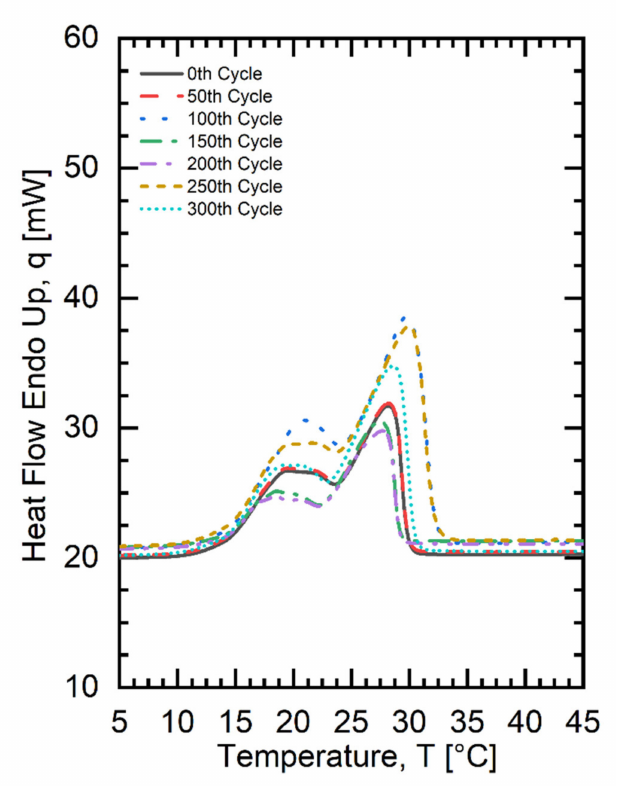
Figure 12. Cycle testing